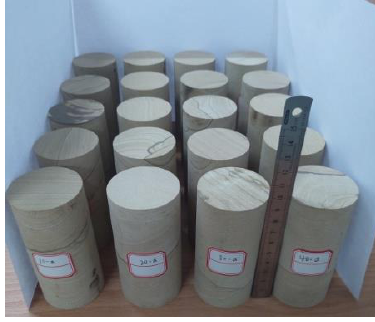
Figure 1. Screened sample.